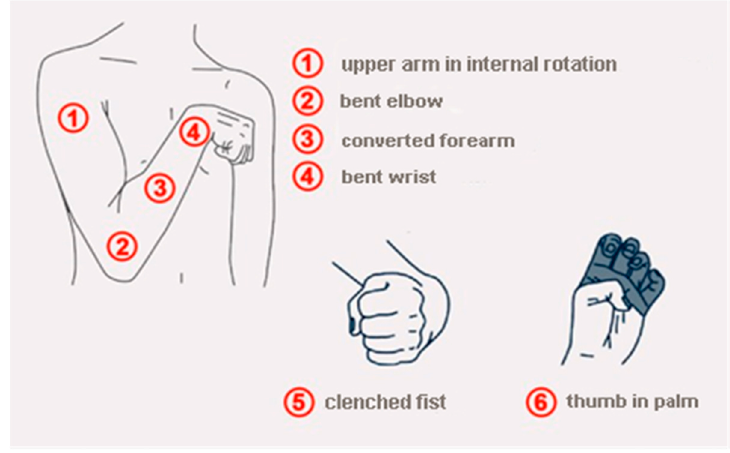
Figure 3. Characteristic features for post-impact spasticity.